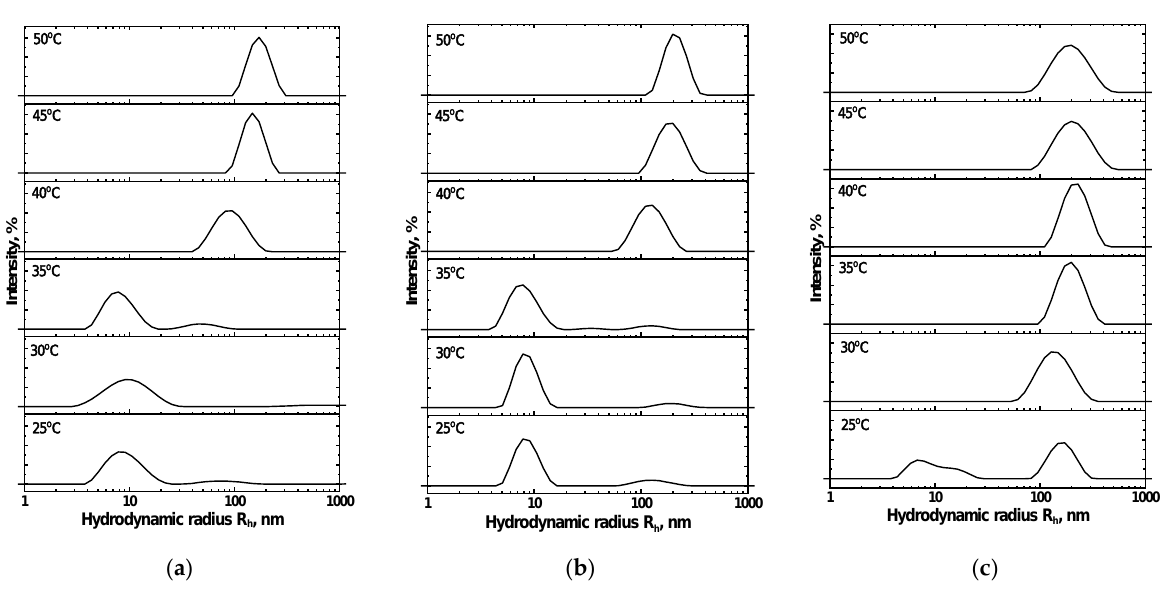
Figure 10. Effect of temperature and ionic strength (μ) on the mean hydrodynamic radius (R h ) of Figure 11. Effect of temperature and ionic strength ( µ ) on the mean hydrodynamic radius (R NIPAM 90 -APTAC 7.5 -AMPS 2.5 : µ = ( a ) 0.001, ( b ) 0.1 and ( c )